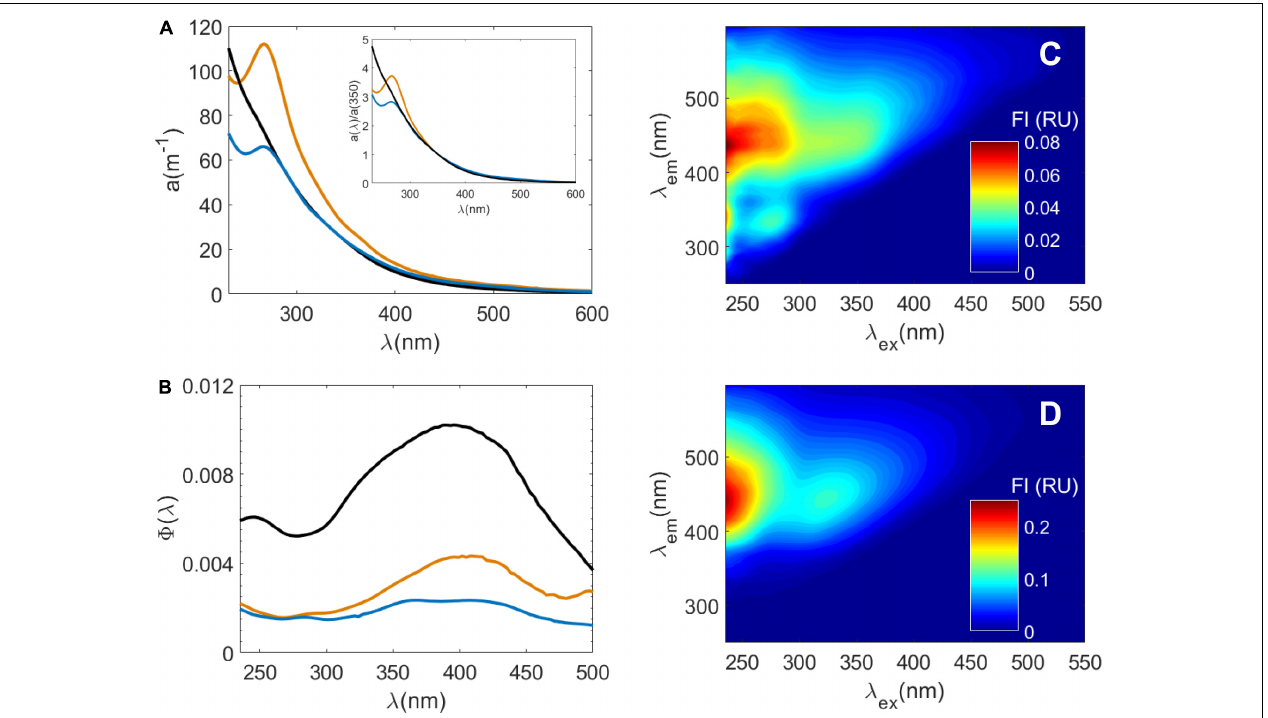
FIGURE 2 | Optical properties of samples used in photochemical irradiation experiments at pH 8: Suwannee River Natural Organic Matter (SRNOM), Sargassum DOM in filtered seawater, and Sargassum SPE-DOM in ultrapure water. (A) a ( λ ) spectra of SRNOM (black line), Sargassum DOM in seawater (orange line), and Sargassum SPE-DOM in ultrapure water (blue line). The inset in (A) are the same a ( λ ) spectra normalized to a ( λ ) at 350 nm [ a ( λ )/ a (350)] to highlight the differences in spectral shape between these samples. (B) Fluorescence apparent quantum yield spectra (cid:56) ( λ ) of Sargassum DOM, Sargassum SPE-DOM and SRNOM where same colors in (A) apply. Excitation-emission matrix spectra of Sargassum SPE-DOM in ultrapure water (C) and SRNOM (D) . Note the difference in scale between the two EEM